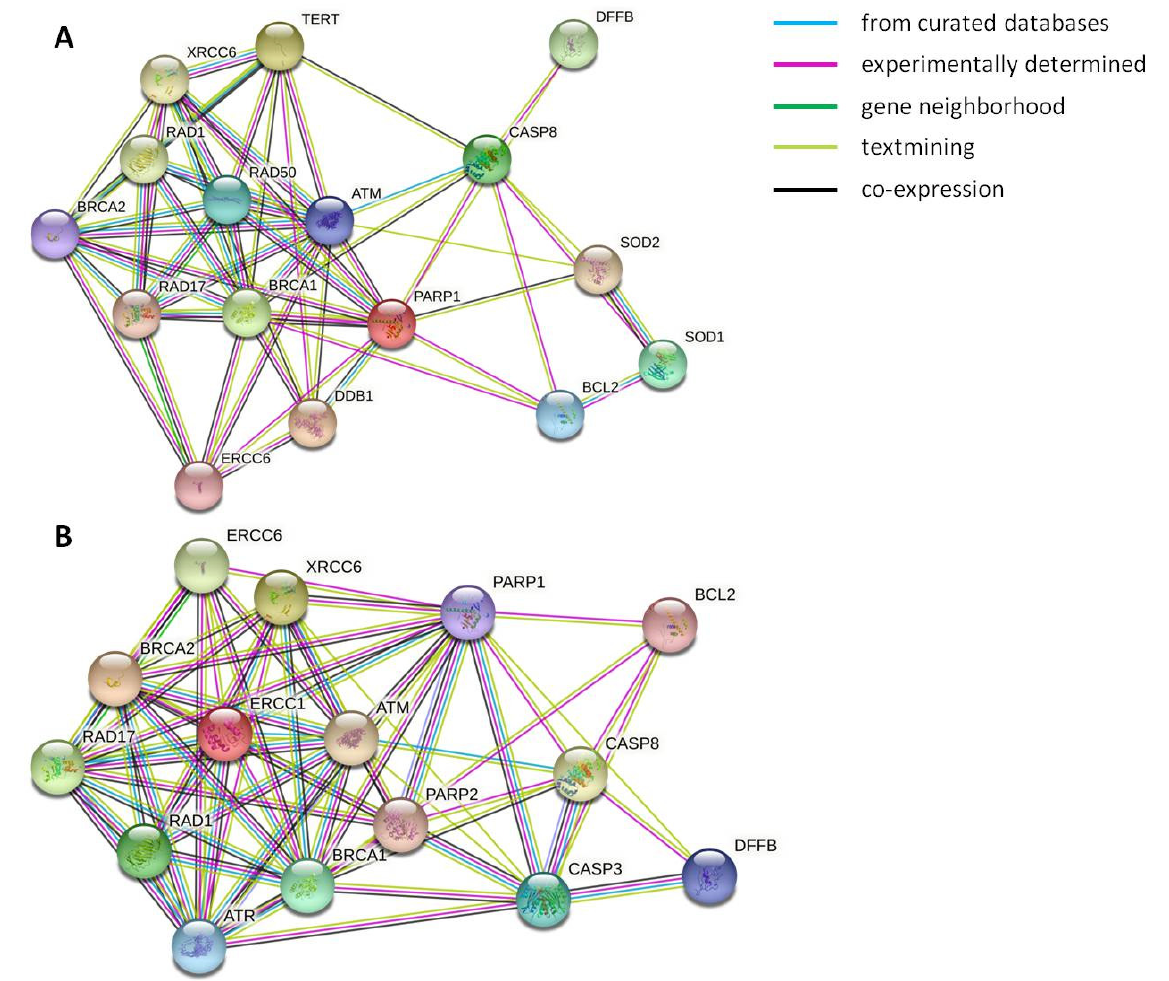
Figure 4. STRING protein–protein interaction network for differentially expressed genes after H 2 O 2 treatment ( A ) and UV-C exposure ( B ). Colored lines between the proteins indicate the various types of interaction evidence: a green line indicates neighborhood evidence; a purple line indicates experimental evidence; a light green line indicates text-mining evidence; a light blue line indicates database evidence; a black line indicates co-expression evidence.